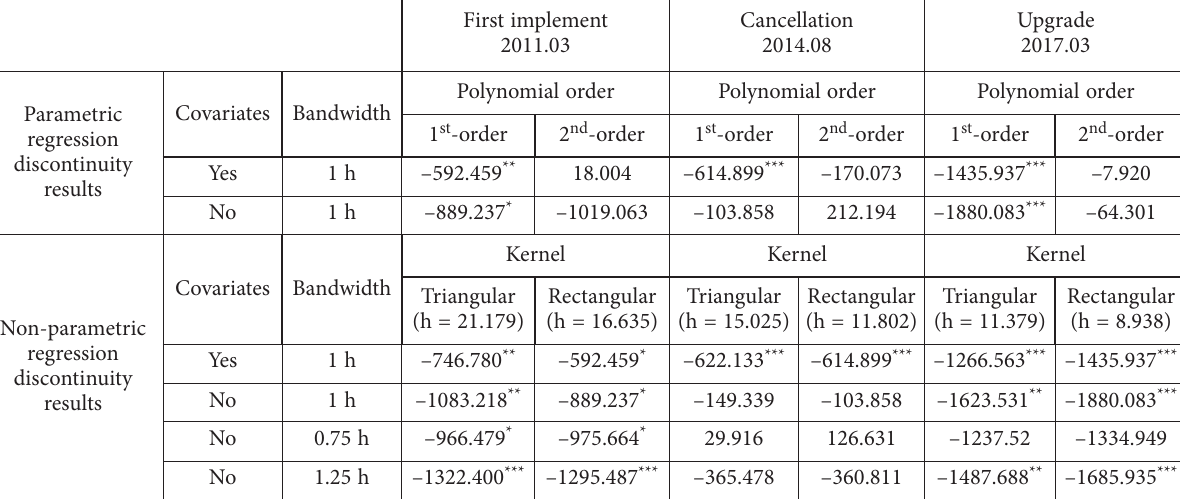
Table 6. Impact of events of home purchase restriction (HPR) using parametric and non-parametric models First implement 2011.03